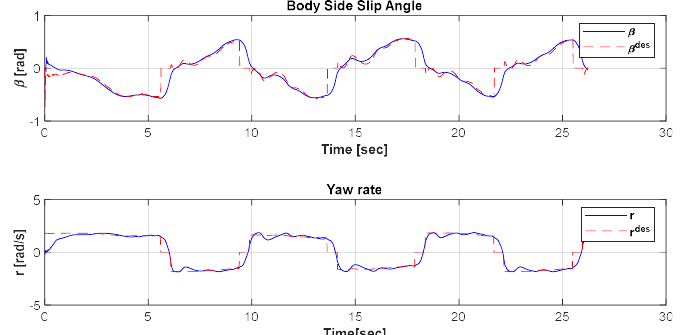
Figure 10. Sideslip angle ( β ) and yaw rate ( r ) of the vehicle during the drift maneuver. The dotted red lines and solid blue lines trace the control-target point of the drift control and the vehicle state, respectively.